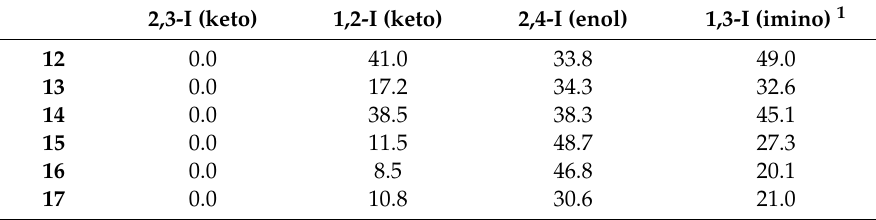
Table 2. The relative energies (kJ / mol) of four tautomers of bicyclic compounds 12 – 17 (Figure 2) calculated at the B3LYP / 6-311 ++ G(2df,2pd)